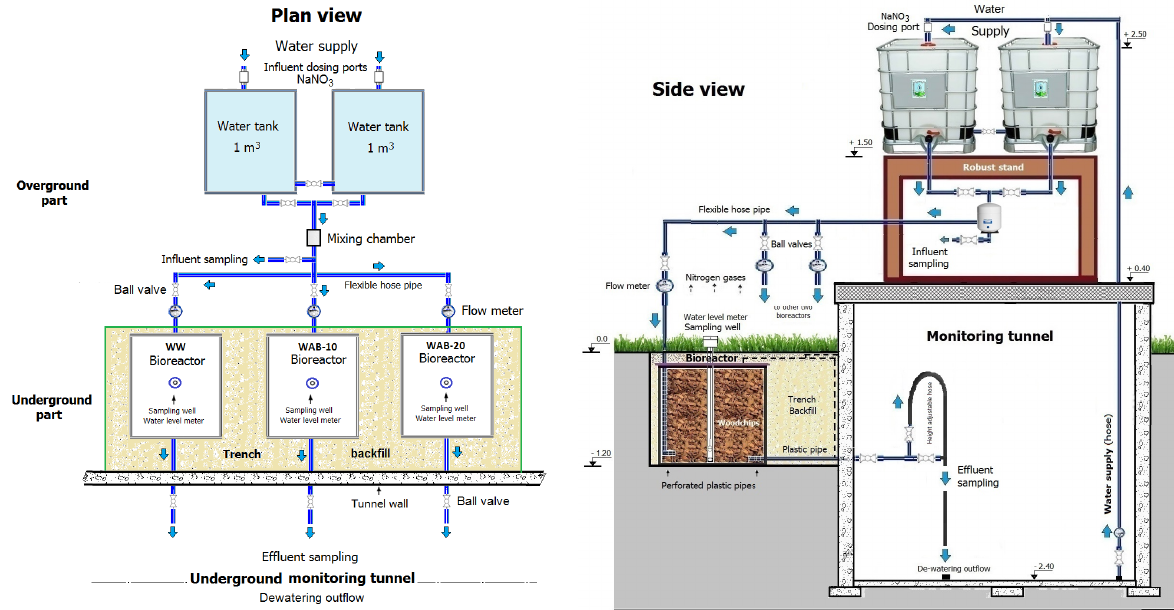
Figure 1. Scheme of the experimental setup with denitrifying bioreactors (WW: woodchips alone; WAB-10 and WAB-20: mixtures of woodchips with 10% and 20% biochar, respectively).